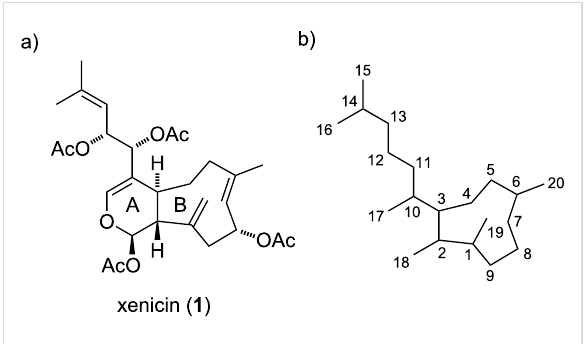
Figure 1: a) Structure of xenicin ( 1 ) and b) numbering of the xenicane skeleton according to Schmitz and van der Helm.